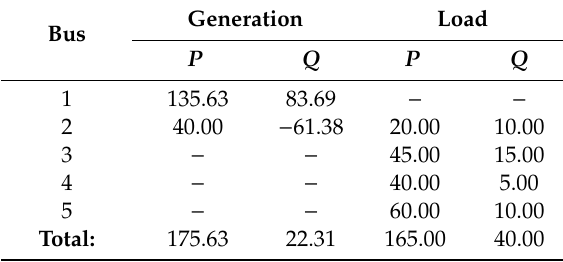
Table A26. Results of the mixed AC / DC PF calculations in Case 6-2. AC bus data.